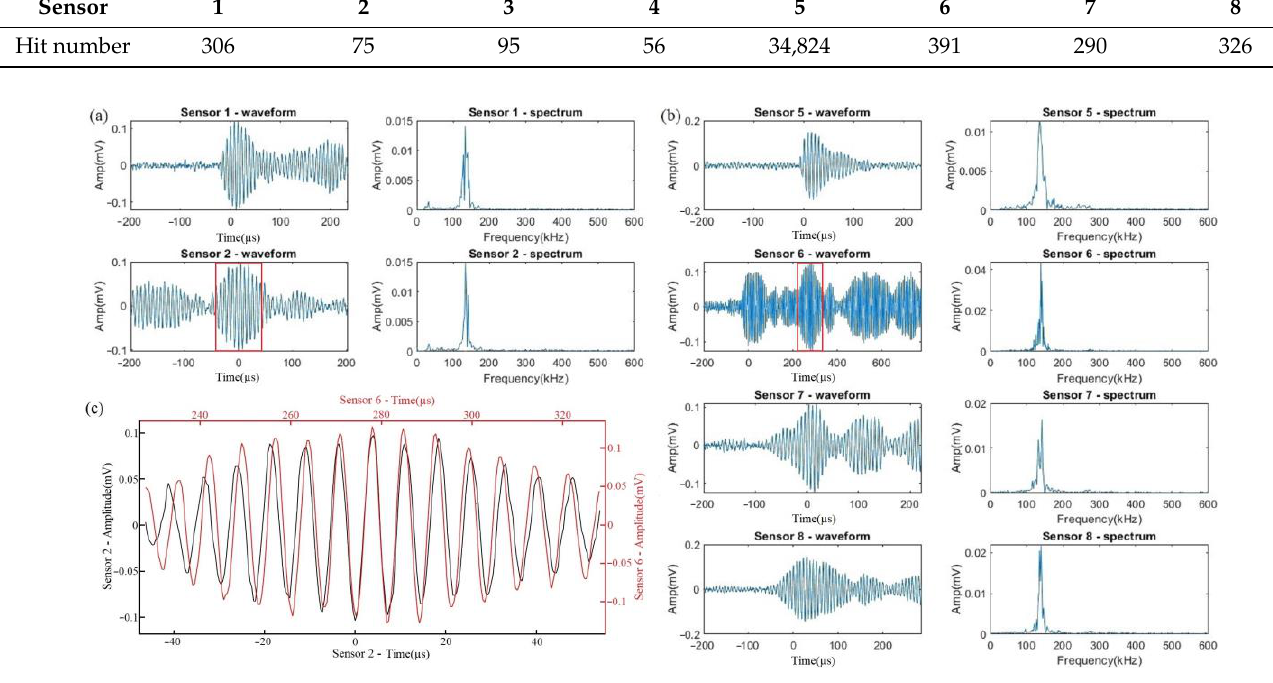
Figure 8. The waveforms and spectrums from the same event of crevice corrosion acquired by ( a ) Nano30 sensors and ( b ) VS150-RIC sensors . Except for the three kinds of signals discussed above, a new cluster of signals ap- peared during this test, which was likely to be from HIC, and is shown in Figure 9. It can